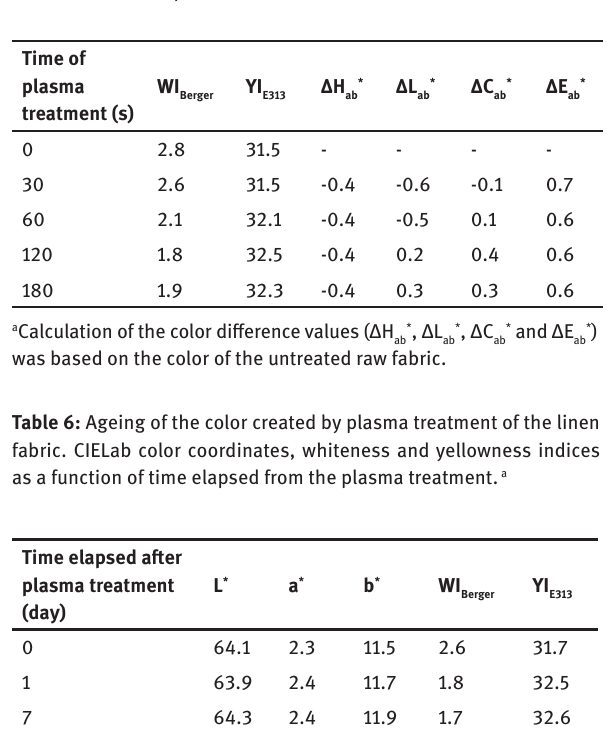
Table 5: Effect of plasma treatment on the color of the linen fabric. Whiteness and yellowness indices and color difference values as a function of time of plasma treatment. a